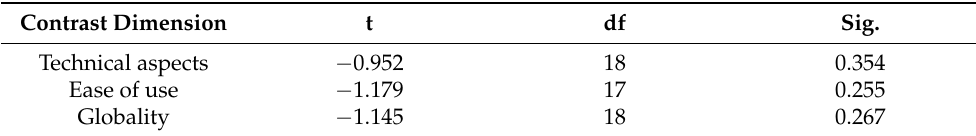
Table 8. Student’s t-test values. Source: developed by the authors. Contrast Dimension t df Sig. Technical aspects